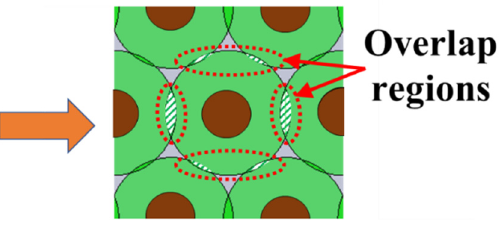
Figure 3. Example of PCM overlap for PCM-wire cylinders when visualized in tube-bank geometry on 𝑟, 𝜃 plane.